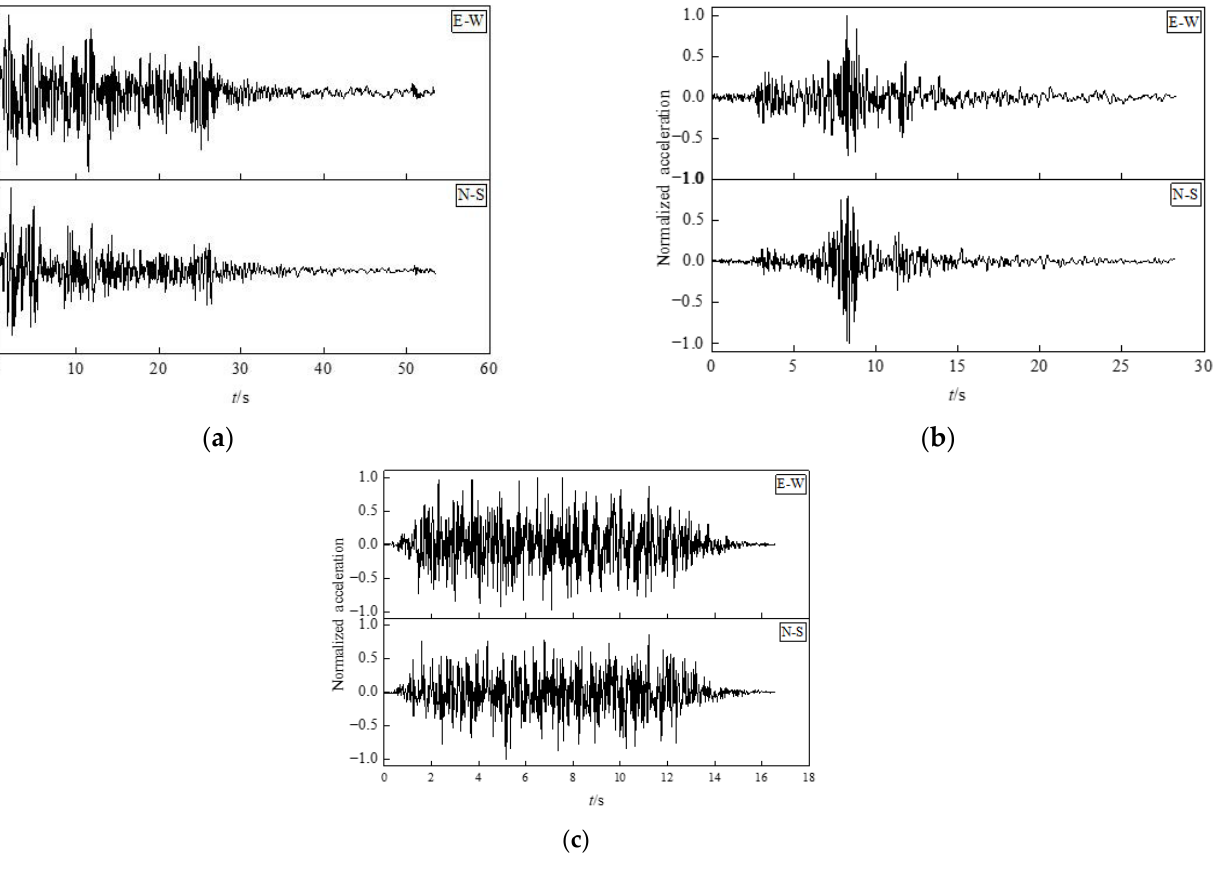
Figure 4. Seismic waves used for the shaking-table tests. ( a ) El Centro; ( b ) Imperial Valley; ( c ) Lanzhou.